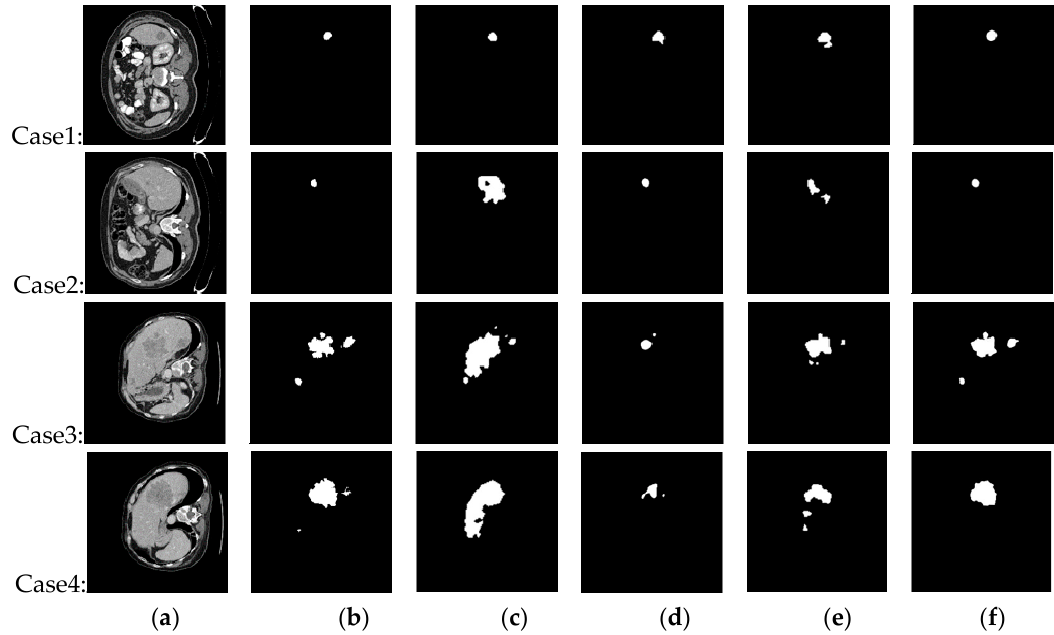
Figure 6. Performance comparison with state-of-art methods: ( a ) Raw CT images, ( b ) Ground truth, ( c ) U-Net [19], ( d ) ResNet [29], ( e ) C-UNet [27], and ( f ) The proposed SED.